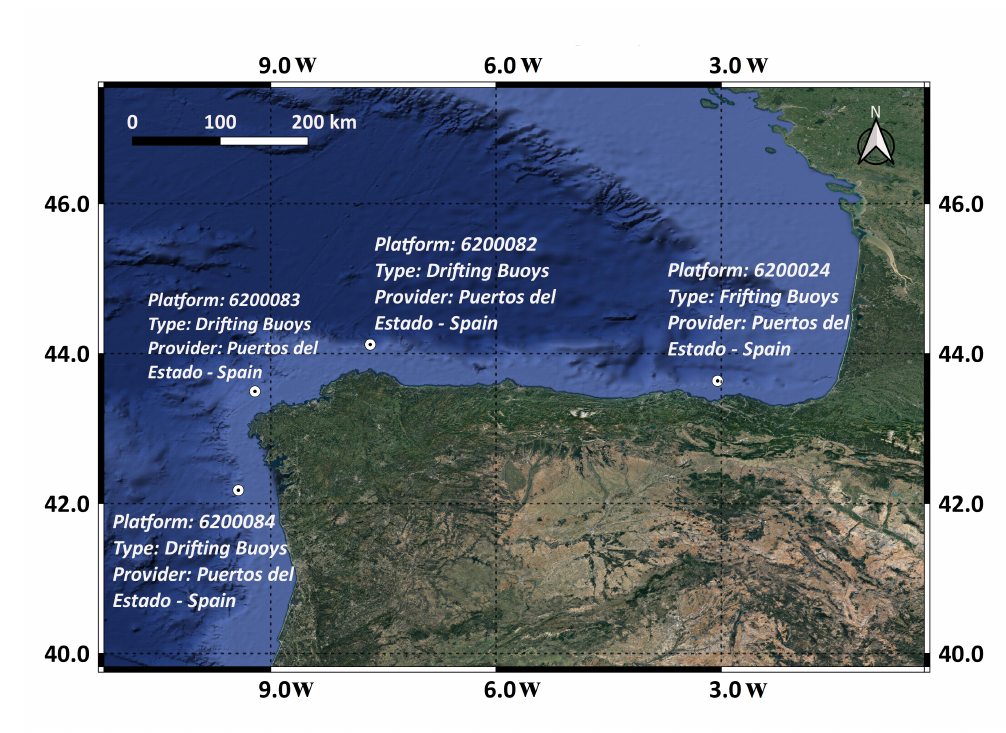
Figure 6. Position and identification code of the drifting buoys platforms used to extract data from EMODNET web portal.